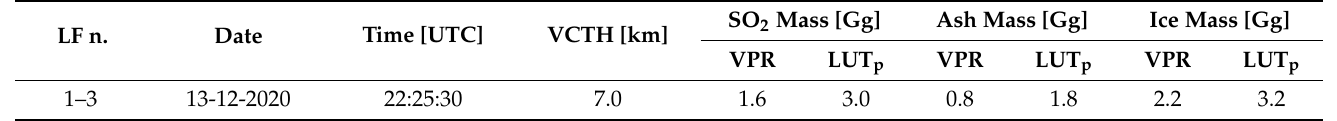
Table A1. List of all the 2020–2022 lava fountains considered. In the first column, the LF numeration according to Calvari and Nunnari [24] is reported. Date and time (2nd and 3rd columns) refer to the time at which the maximum of VCTH from the DP method was obtained; 10 m and 30 s were added to SEVIRI starting acquisition time to account for the position of Etna in the “Earth Full-Disk” image. The 4th column indicates the mean weighted VCTH obtained by applying Equations (1)–(3). Finally, columns 5th–10th report the maximum ash/ice/SO 2 total mass values obtained from VPR and LUT p procedures applied to SEVIRI images. For SO 2 only, the maximum in the time range between the start and the end (+1 h) of the eruption was